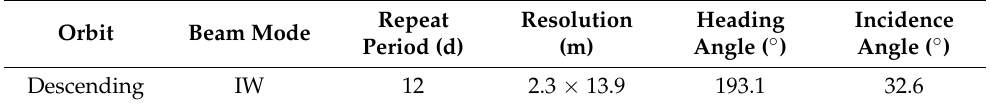
Table 1. Sentinel-1 SAR image parameters.